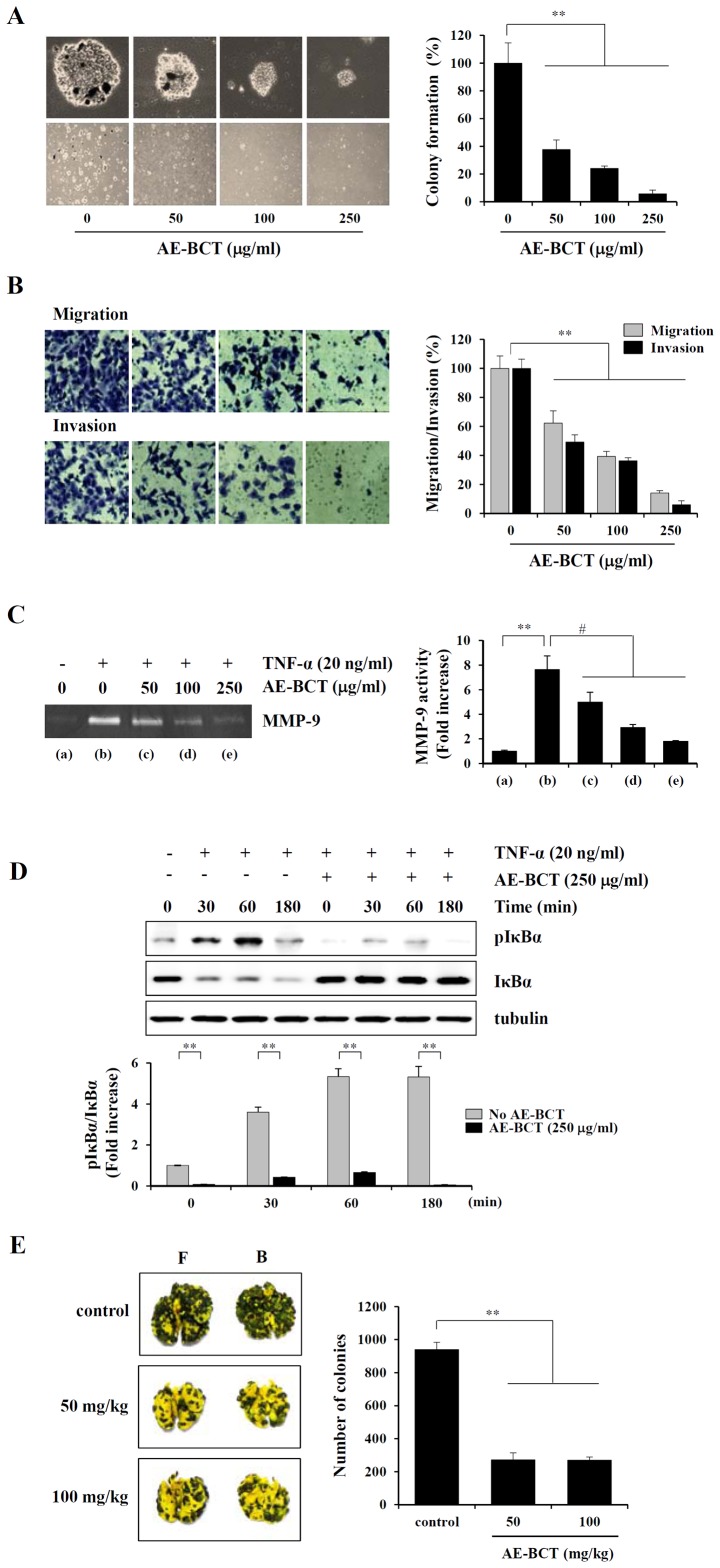
Effect of AE-BCT on the in vitro metasatic potential and in vivo pulmonary metastasis of B16F10 cells.(A) To examine anchorage-independent cell growth, a soft agar colony formation assay was performed. After 10 days of incubation with or without AE-BCT, colonies were observed (upper ×200, lower ×40) and the diameters of 20 representative colonies were measured. (B) B16F10 cells pre-treated with or without AE-BCT for 12 h were examined for Transwell migration and invasion capabilities. Data are expressed as means ± SD of two independent experiments. **p<0.01 vs untreated control (C) Cells pre-treated with AE-BCT for 12 h were incubated in serum-free medium with 20 ng/mL TNF-α for a further 24 h. Conditioned media were collected and analyzed for the activity of MMP-9 by gelatin zymography. **p<0.01 vs untreated control, #
p<0.01 vs TNF-α stimulation (D) Control and AE-BCT-pre-treated B16F10 cells were stimulated with 20 ng/ml TNF-α for the 30, 60, and 180 min and cell lysates were examined for the phosphorylation and degradation of IκBα. After normalization to α-tubulin expression, relative ratios of pIκBα/IκBα were determined. Data are expressed as means ± SD of two independent experiments. **p<0.01 vs no AE-BCT (E) Cells (3×105/200 µL PBS) were injected into the tail veins of 6-week-old female C57BL/6J mice, to which AE-BCT (50 or 100 mg/kg) was administered daily. At day 17, mice were killed and the black colonies on the lung surface were enumerated macroscopically. Images of metastatic lung nodules at the front (F) and back (B) are shown. Colonies were enumerated and relative inhibition compared with the control group was calculated. Data are representative of two independent experiments (n = 5 per group). **p<0.01 vs saline control.